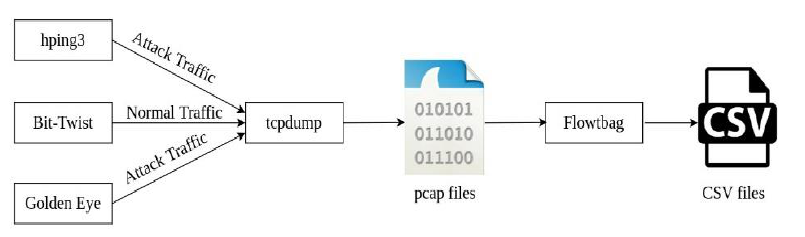
Figure 4. Architectural framework for dataset generation.